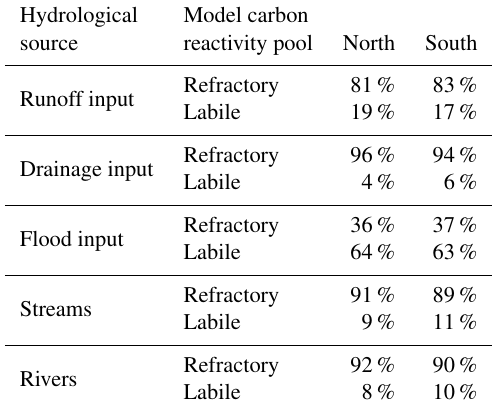
Table 2. Summary of the average carbon reactivity types compris- ing the hydrological inputs to rivers and streams (runoff, drainage, and floodplain inputs), and within the rivers and streams them- selves, subdivided between the north and south of the Lena basin (greater or less than 63 ◦ N,